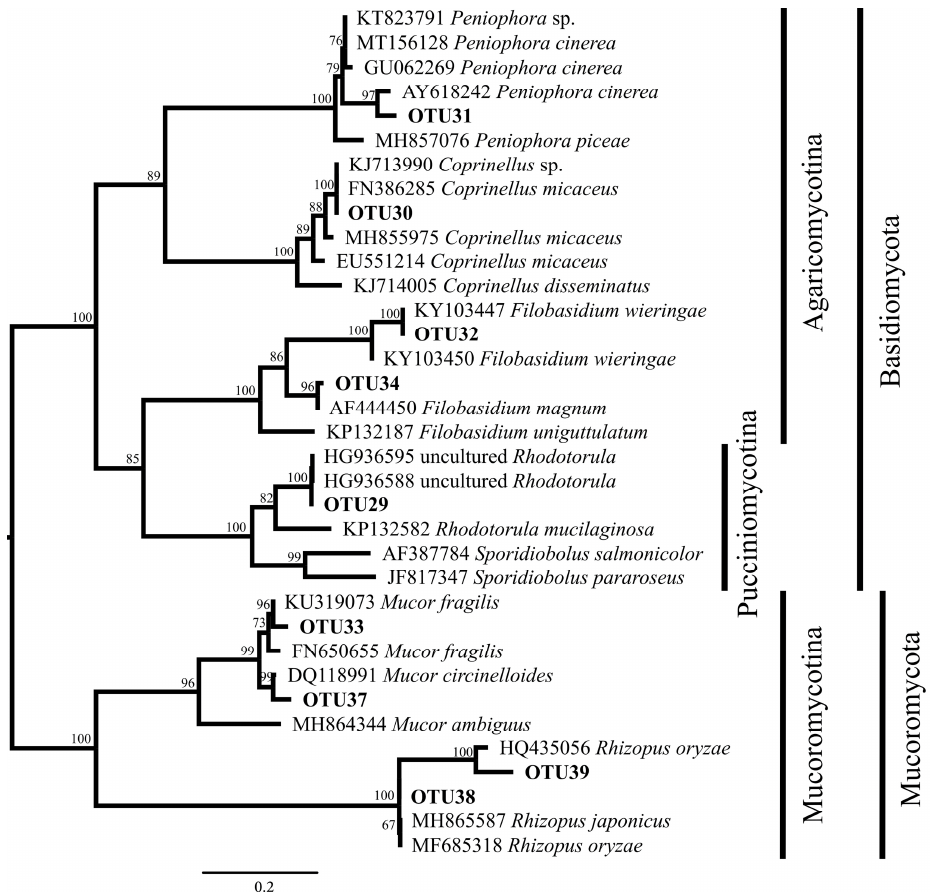
Figure 2. Phylogenetic tree of Basidiomycota and Mucoromycota OTUs identified in this study (in bold). Numbers near the branches indicate bootstrap values (percentage over 1000 replicates).